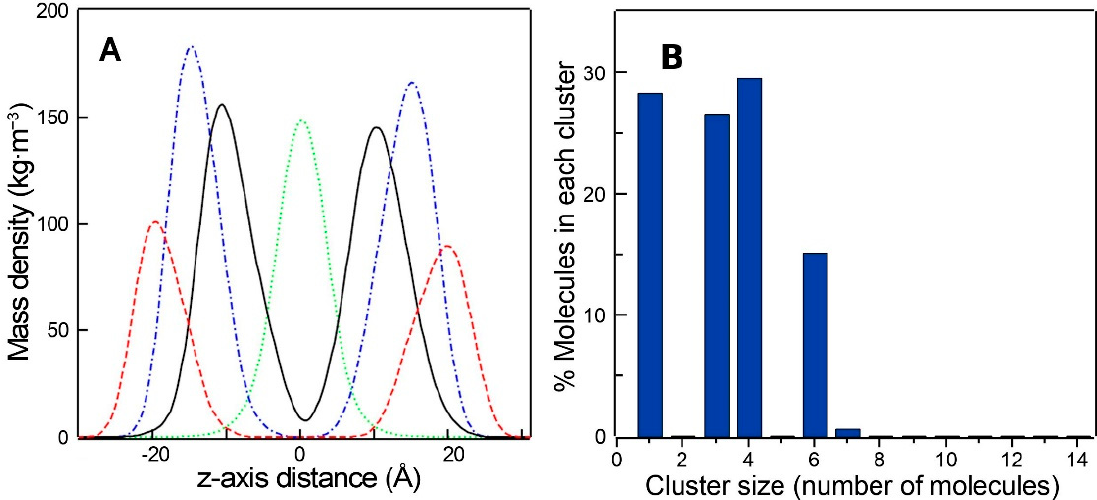
Figure 8. ( A ) Non-symmetrized mass density profiles along the z -axis of the simulation box of DMPG/TMBC system at 308 K. TMBC molecule in solid black line, phosphorus atoms in dashed red line, lipid carbonyl groups in blue dash one dot line and lipid terminals methyl carbon atoms in green dotted lines. ( B ) Cluster size distribution of TMBC molecules in the DMPG bilayer.